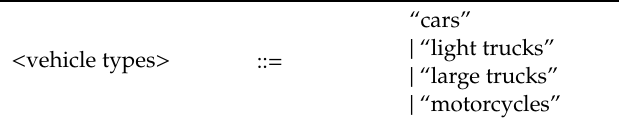
Table A9. The 4th stage of < environment >< objects >< roadway users >